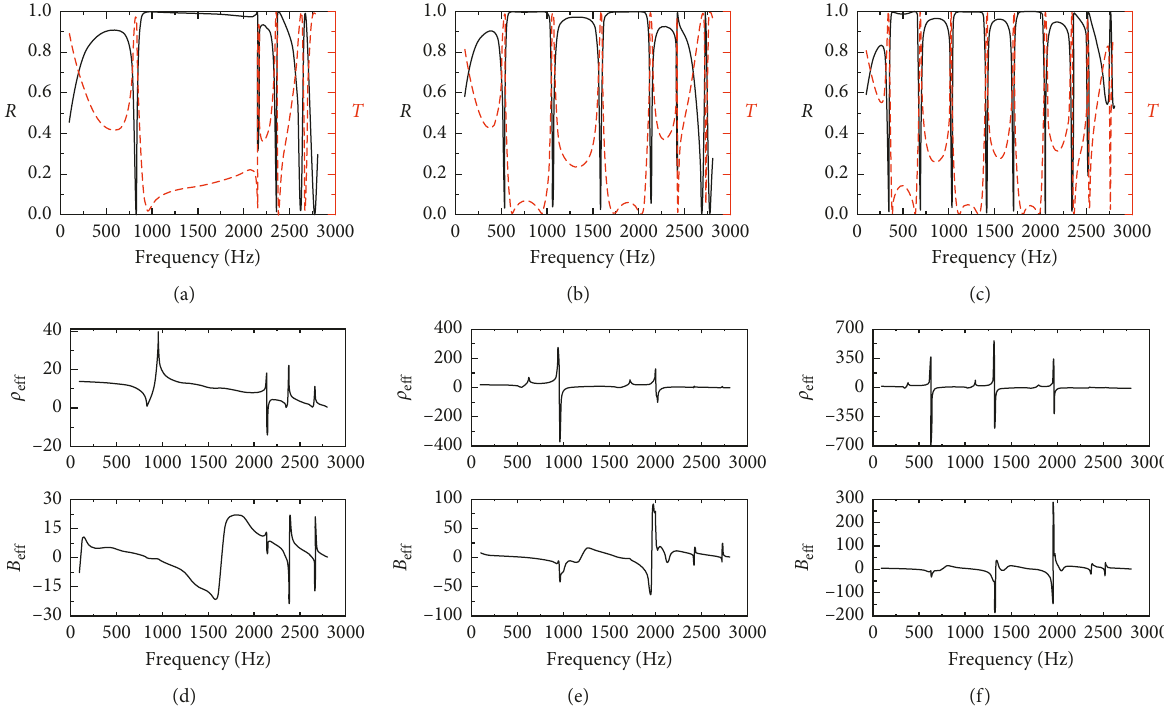
Figure 3: (a–c) Reflection and transmission coefficients of the fractal acoustic structures from the first order to third order. (d–f) Effective parameter calculation results for the fractal acoustic structures from the first order to third